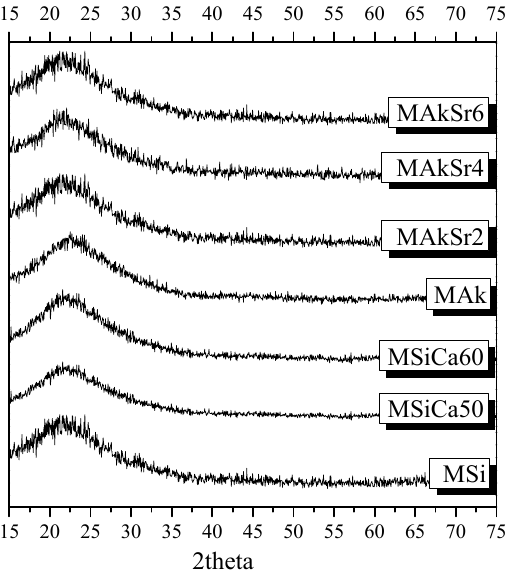
Figure 2. XRD diffractograms of the synthesized mesoporous silica-based nanoparticles (MSNs).